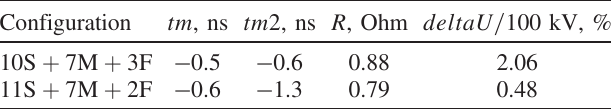
Please note that tm ¼ − 0 . 6 ns in Table I indicates that the switches in the 3rd harmonic bricks are closed 0.6 ns before the closure of the switches in the standard bricks. tm 2 ¼ − 1 . 3 ns indicates, the switches in the 5th harmonic bricks close 1.3 ns before those in the standard bricks. Positive values mean that these switches are closed after the closure of the standard brick